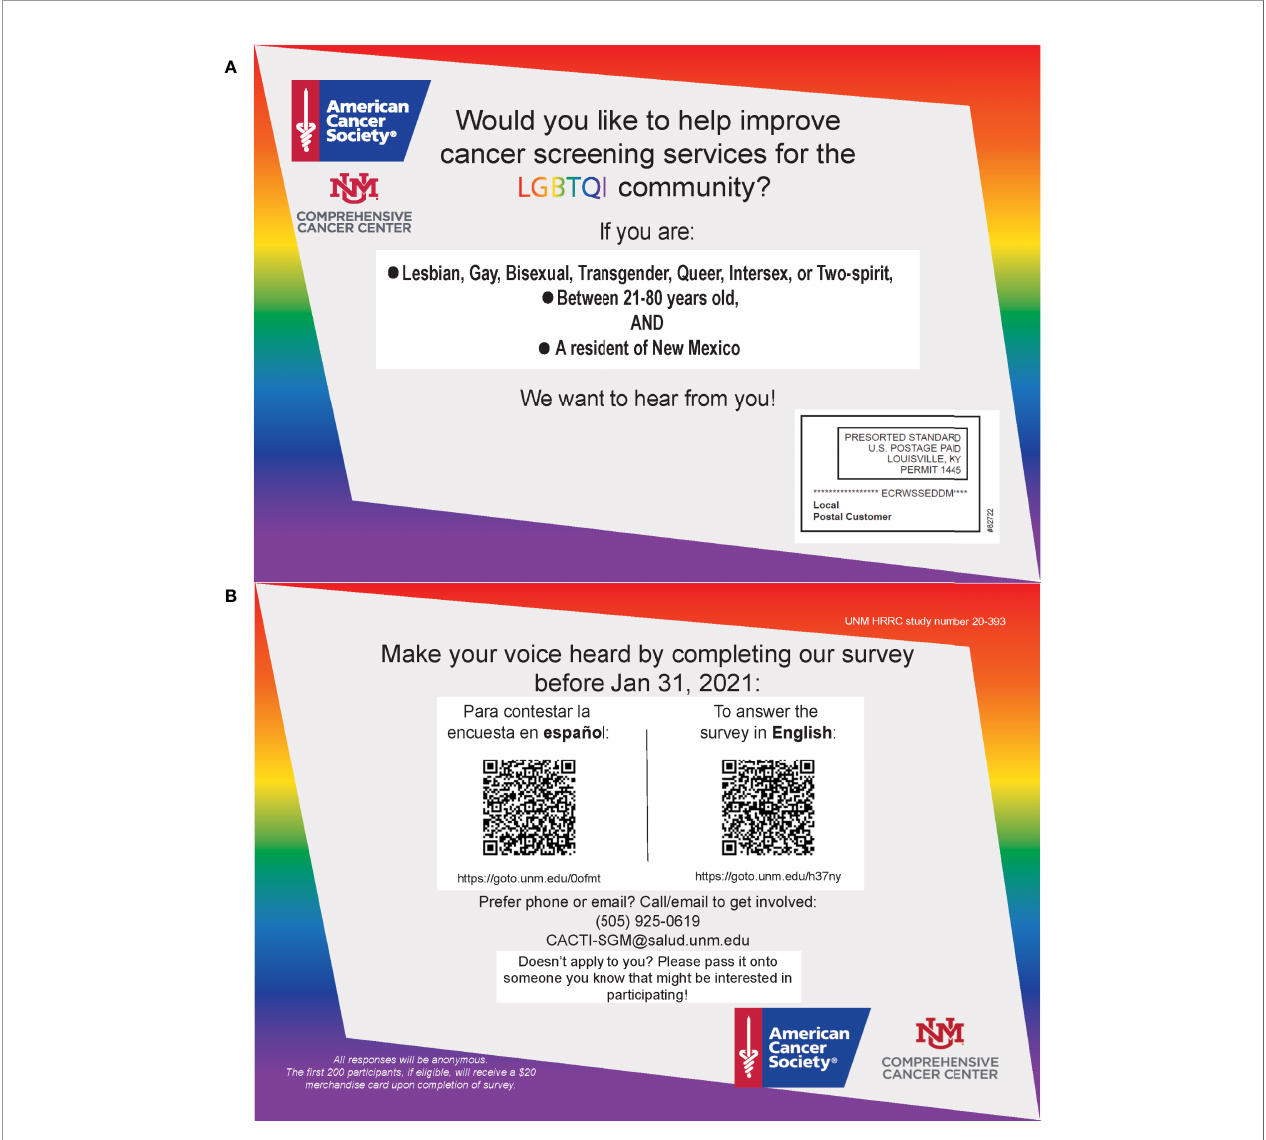
FIGURE 2 | Flyers created for the study (A) Front of fl yer, (B) Back of fl